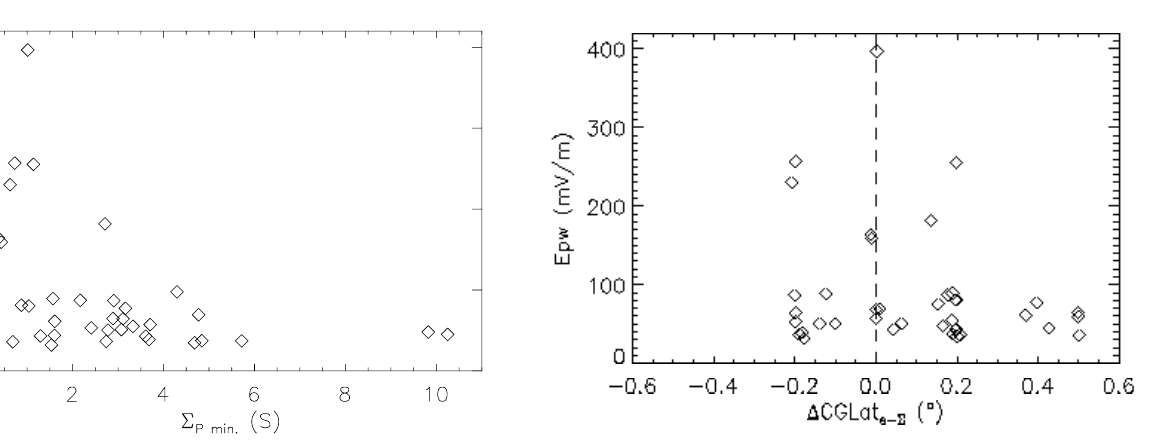
Fig. 7. Distribution of the electric field peak intensity ( E pw ) versus the value of the corresponding conductivity minimum ( 6 p min. ).